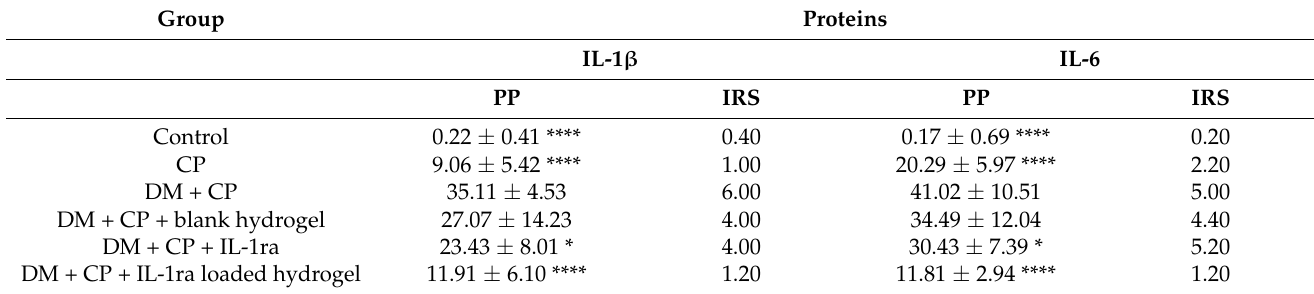
Table 2. The proportion of different protein positive cells in diabetic periodontitis rat